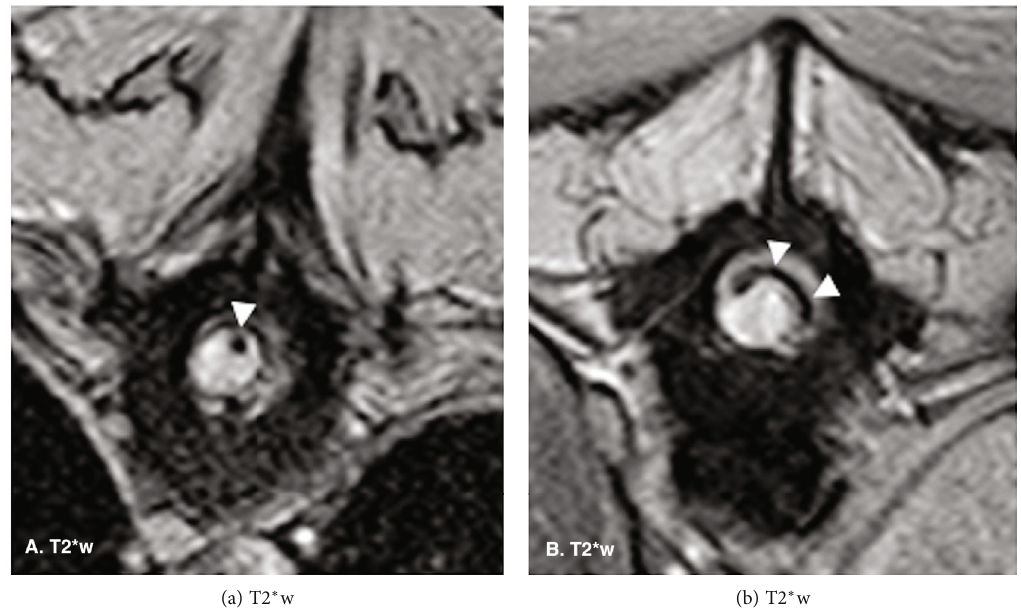
Figure 3: MRI gradient eco transverse planes at T9 level show an intramedullary round focal signal void in the dorsal funiculus (arrow in (a)) characteristic of haemorrhage and a dorsolateral hypointense rim at T12 level (arrows in (b)) compatible with subdural haematoma, with hemosiderin creating the magnetic susceptibility variation depicted on this